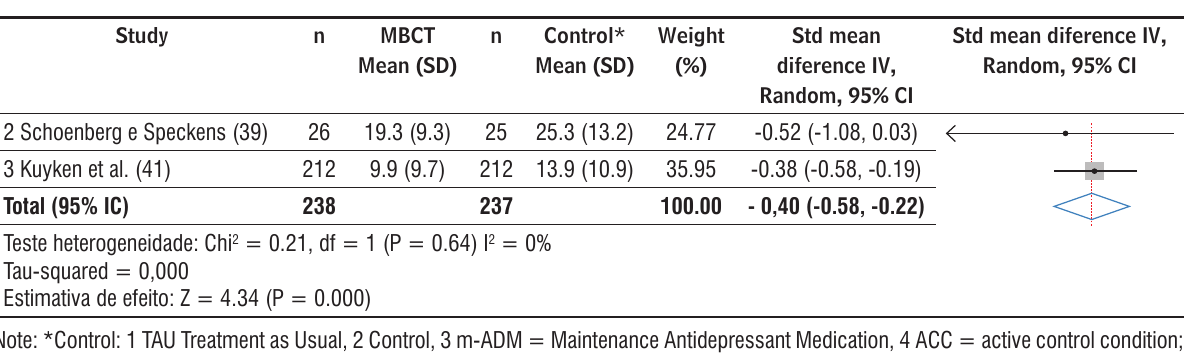
Figure 3 - Forest plot showing effects of MBCT on